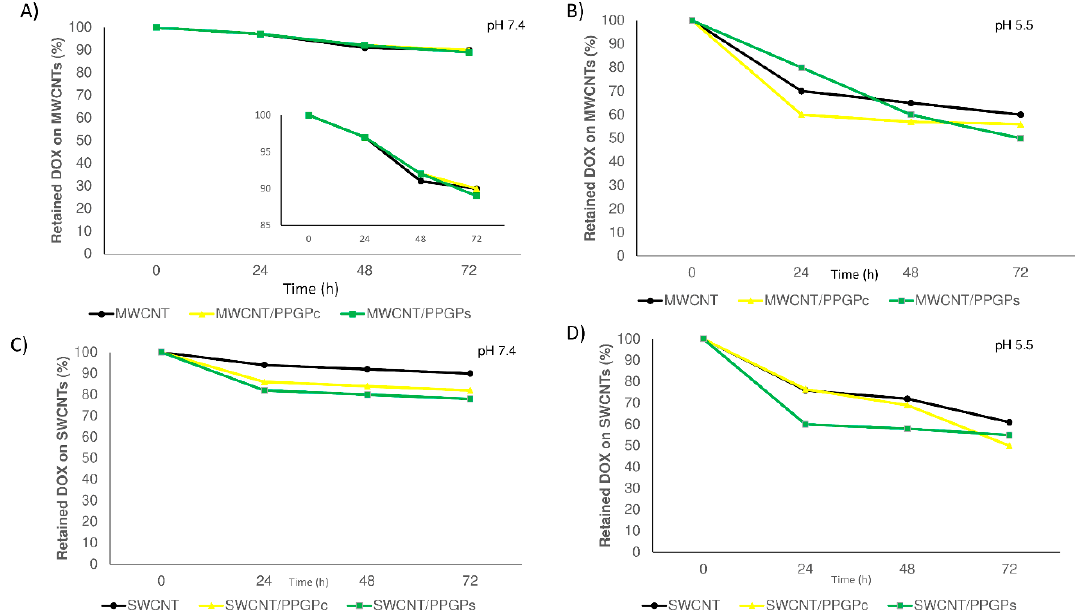
Figure 11. Drug release of the unmodified CNT/DOX and modified CNT/PPGP/DOX nano complexes in PBS buffer at 37 °C at pH 7.4 ( A , C ), MWCNT s and SWCNT s respectively) and in acetate buffer at pH 5.5 ( B , D ), MWCNTs and SWCNTs respectively); magnification in the range from 85% to 100% of retained DOX on MWCNT is also reported in the y-axis ( A ).